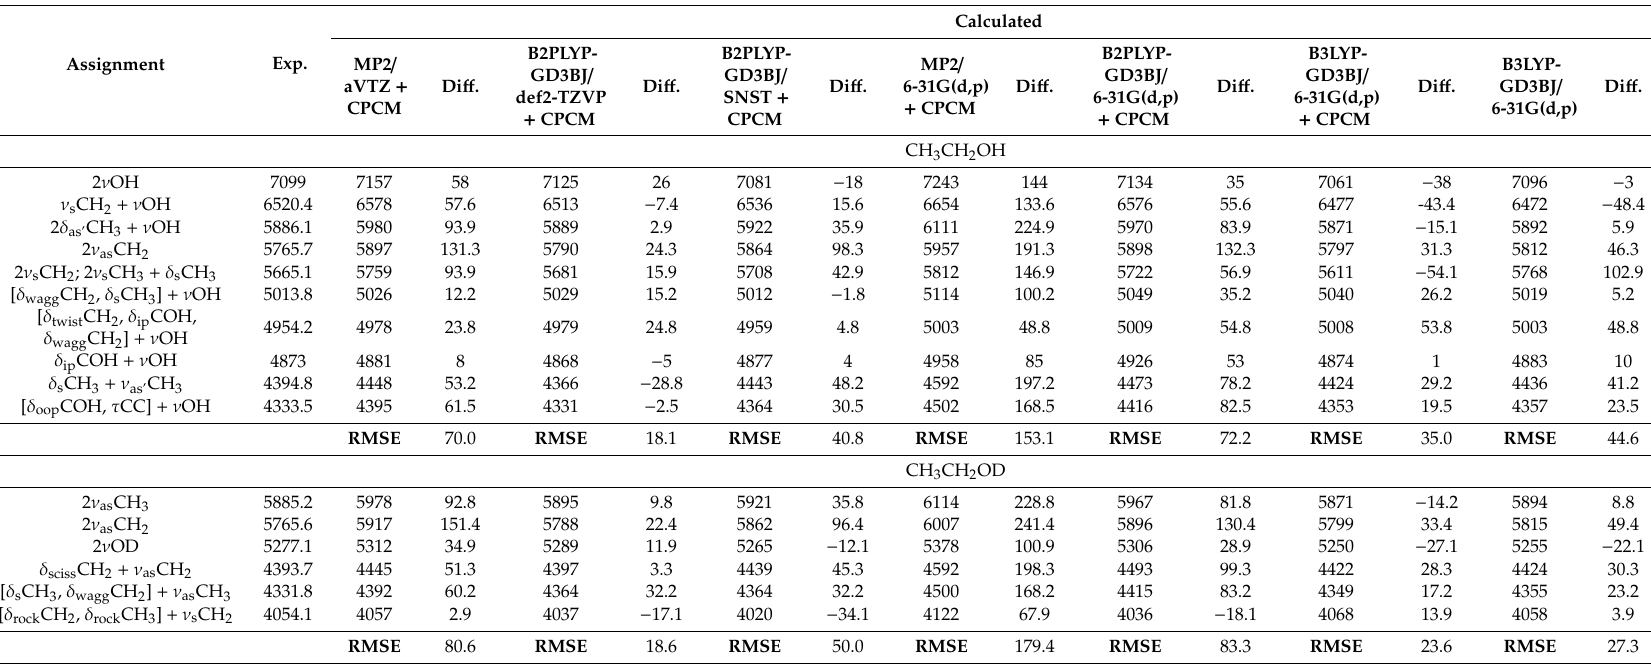
Table 1. Positions of selected NIR bands (in cm − 1 ) from GVPT2 anharmonic vibrational analysis in CH 3 CH 2 OH and CH 3 CH 2 OD at di ff erent levels of electronic theory and corresponding RMSE